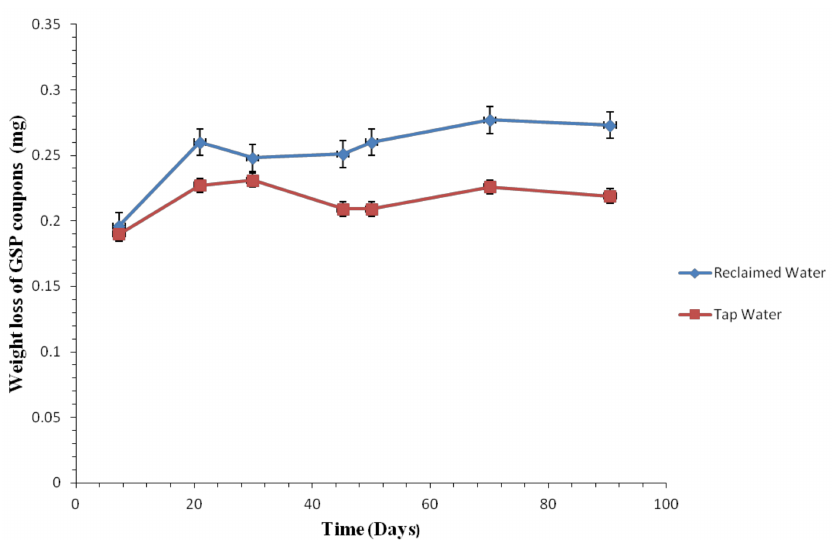
Figure 13. Weight loss of galvanized steel pipe coupons with RW and TW over time with standard error bars.